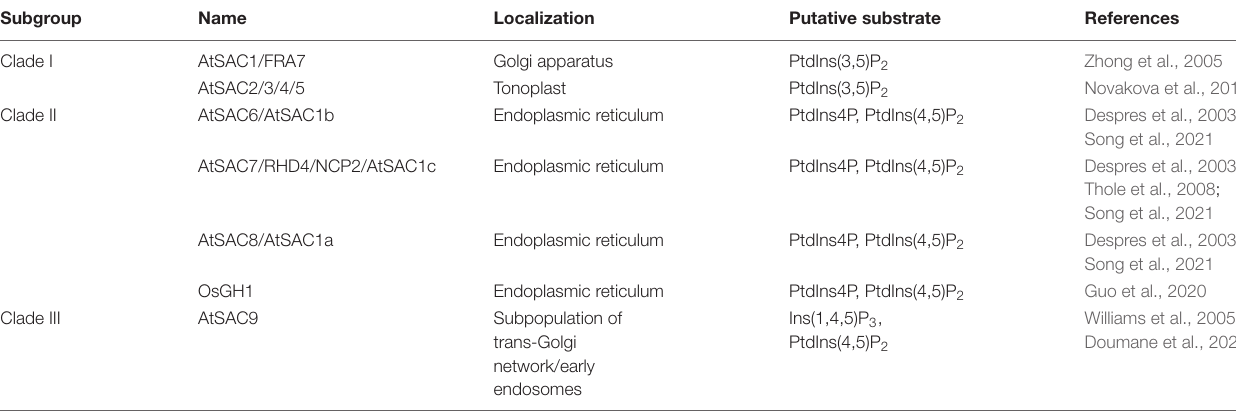
TABLE 1 | Subcellular localization and substrate specificity of currently characterized plant SAC family